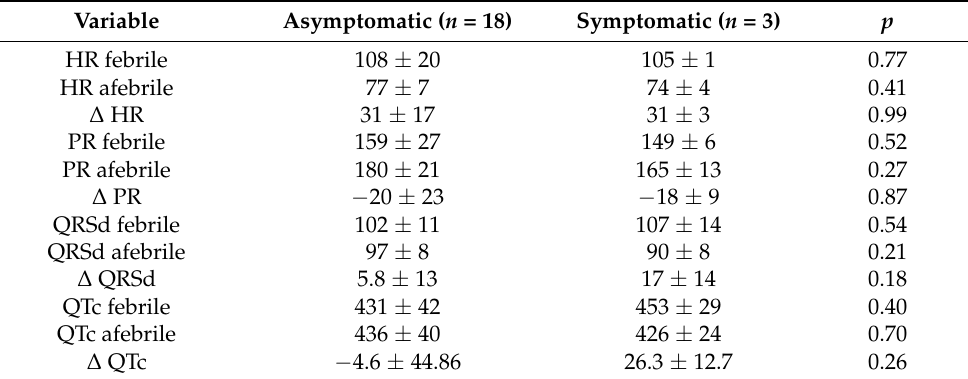
(Table 2). During fever, the heart rate was significantly higher than that at afebrile status in the asymptomatic group (108 ± 20 beats/min vs. 77 ± 7 beats/min; p < 0.001) and in the symptomatic group (105 ± 1 beats/min vs. 74 ± 4 beats/min; p < 0.001), while the PR interval was significantly shorter than that at afebrile status in the asymptomatic group (159 ± 27 ms vs. 180 ± 21 ms; p < 0.05) and in the symptomatic group (149 ± 6 ms vs. 165 ± 13 ms; p < 0.05). However, the increase in heart rate and the decrease in PR interval during fever were not significantly different between the symptomatic and asymptomatic groups ( p > 0.05). QRS duration during fever was not significantly different from that at afebrile status in both the asymptomatic group (102 ± 11 ms vs. 97 ± 8 ms; p = 0.09) and the symptomatic group (107 ± 14 ms vs. 90 ± 8 ms; p = 0.14). The corrected QT interval during fever was not significantly different from that at afebrile status in both the asymptomatic group (431 ± 42 ms vs. 436 ± 40 ms; p = 0.74) and the symptomatic group (453 ± 29 ms vs. 426 ± 24 ms; p = 0.29). Changes in QRS duration and corrected QT intervals during fever were not significantly different between the symptomatic and asymptomatic groups ( p > 0.05). Table 2. ECG parameters during fever and in the afebrile state between the two groups. Variable Asymptomatic ( n = 18) Symptomatic ( n = 3) p HR febrile 108 ± 20 105 ± 1 0.77 HR afebrile 77 ± 7 74 ± 4 0.41 ∆ HR 31 ± 17 31 ± 3 0.99 PR febrile 159 ± 27 149 ± 6 0.52 PR afebrile 180 ± 21 165 ± 13 0.27 ∆ PR − 20 ± 23 − 18 ± 9 0.87 QRSd febrile 102 ± 11 107 ± 14 0.54 QRSd afebrile 97 ± 8 90 ± 8 0.21 ∆ QRSd 5.8 ± 13 17 ± 14 0.18 QTc febrile 431 ± 42 453 ± 29 0.40 QTc afebrile 436 ± 40 426 ± 24 0.70 ∆ QTc − 4.6 ± 44.86 26.3 ± 12.7